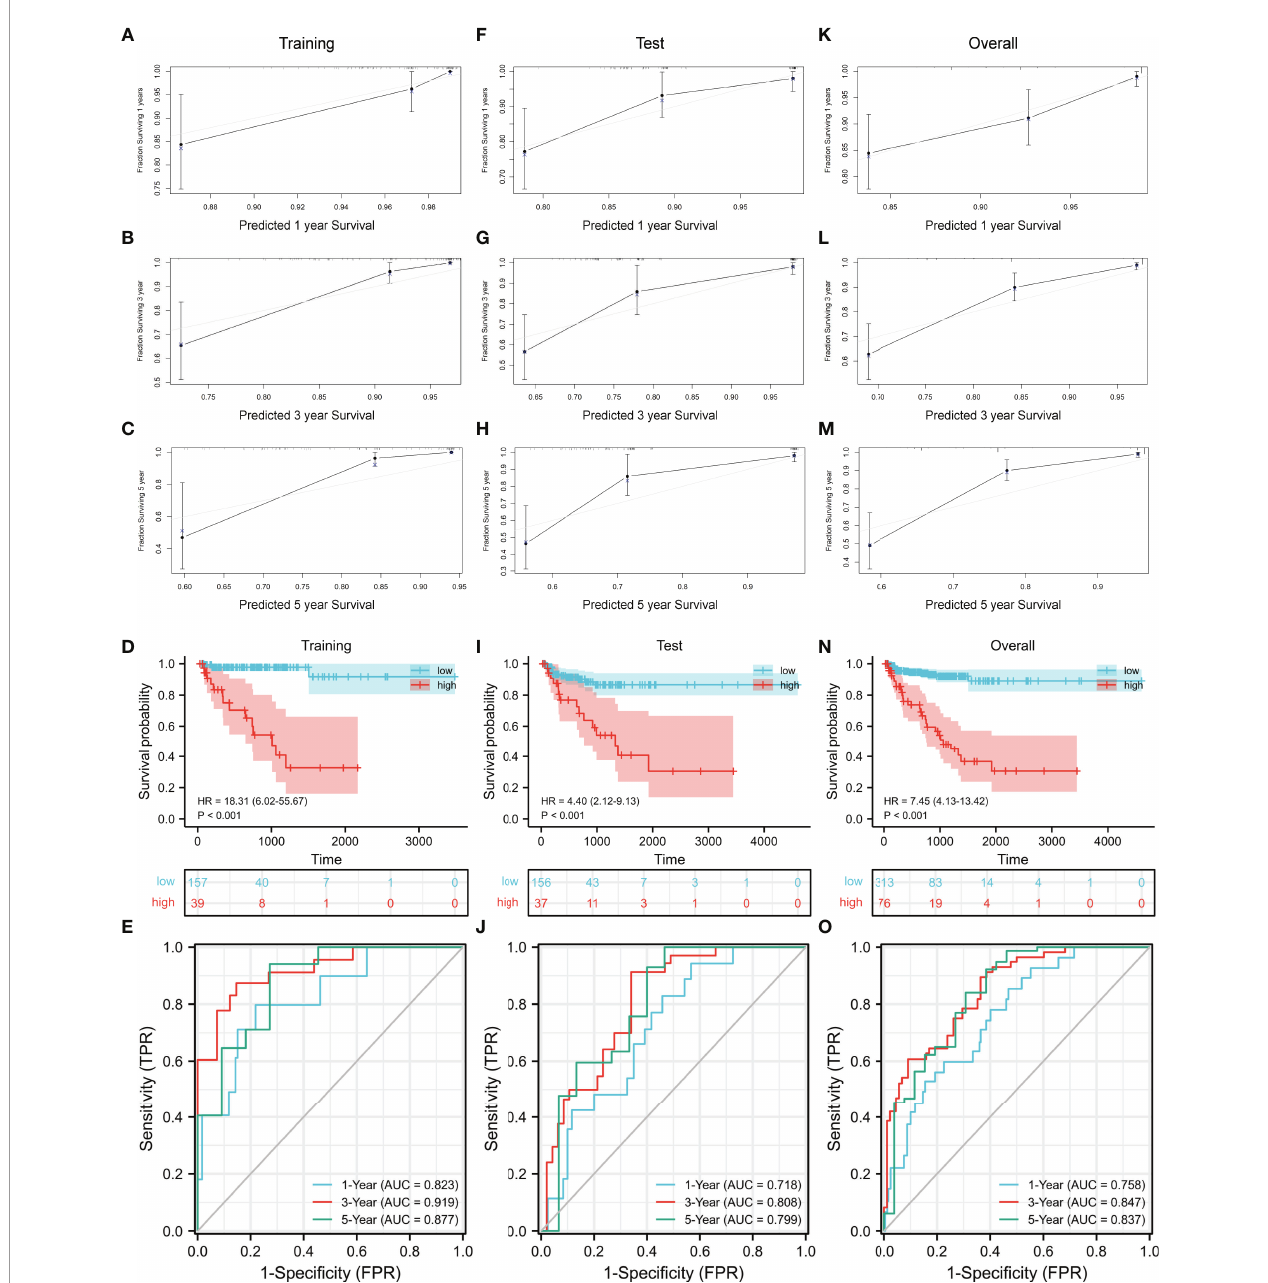
FIGURE 7 | Evaluation and validation of the nomogram model. (A – C) Evaluation of the nomogram model with calibration curves in 1, 3, and 5 years. Evaluation of the nomogram model with Kaplan – Meier analysis (D) and ROC curves (E) . Validation of the nomogram model with calibration curves in the test set (F – H) and overall TCGA cohort (K – M) . Validation of the nomogram model with Kaplan – Meier analysis (I) and ROC curves (J) in the test set. Validation of the nomogram model with Kaplan – Meier analysis (N) and ROC curves (O) in the overall TCGA cohort. ROC, receiver operating characteristic; TCGA, The Cancer Genome